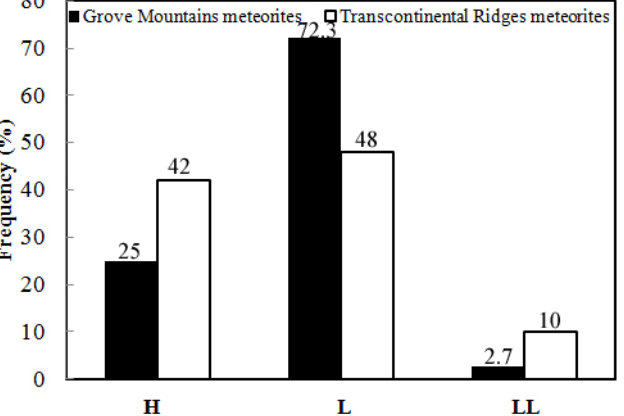
Figure 4. Comparison of the distribution patterns of the chondrite chemical groups between the Transcontinental regions and the Grove Mountains.